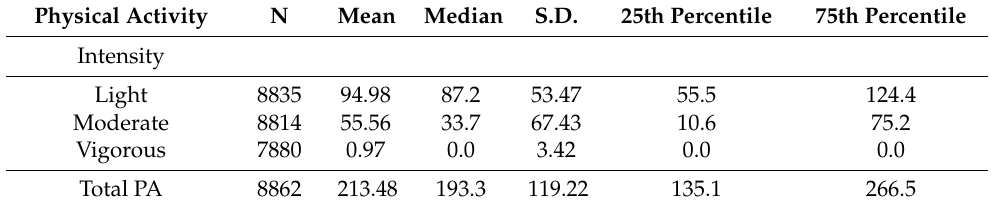
Table 2. Physical activity energy expenditure (MET-h/week) classified according to its intensity.